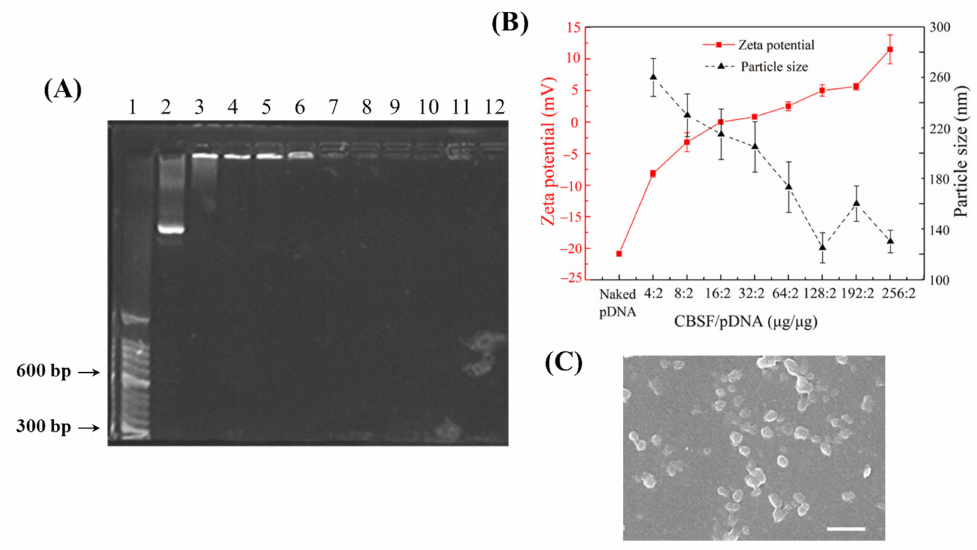
Figure 4. ( A ) Agarose gel electrophoresis of naked pDNA, CBSF/pDNA complexes and PEI/pDNA complexes. Lane 1: marker; lane 2: naked pDNA; lanes 3–10: CBSF/pDNA complexes at w / w ratios of 4/2, 8/2, 16/2, 32/2, 64/2, 128/2, 196/2, and 256/2; lane 11: 1.8 kDa PEI/pDNA complex at a w / w ratio of 10/3; lane 12: 25 kDa PEI/pDNA complex at a w / w ratio of 10/2. ( B ) Zeta potentials and particle sizes of complexes at different CBSF/pDNA weight ratios. ( C ) Scanning electron microscopy image of the CBSF/pDNA complex at a w / w ratio of 256/2. Scale bar: 400